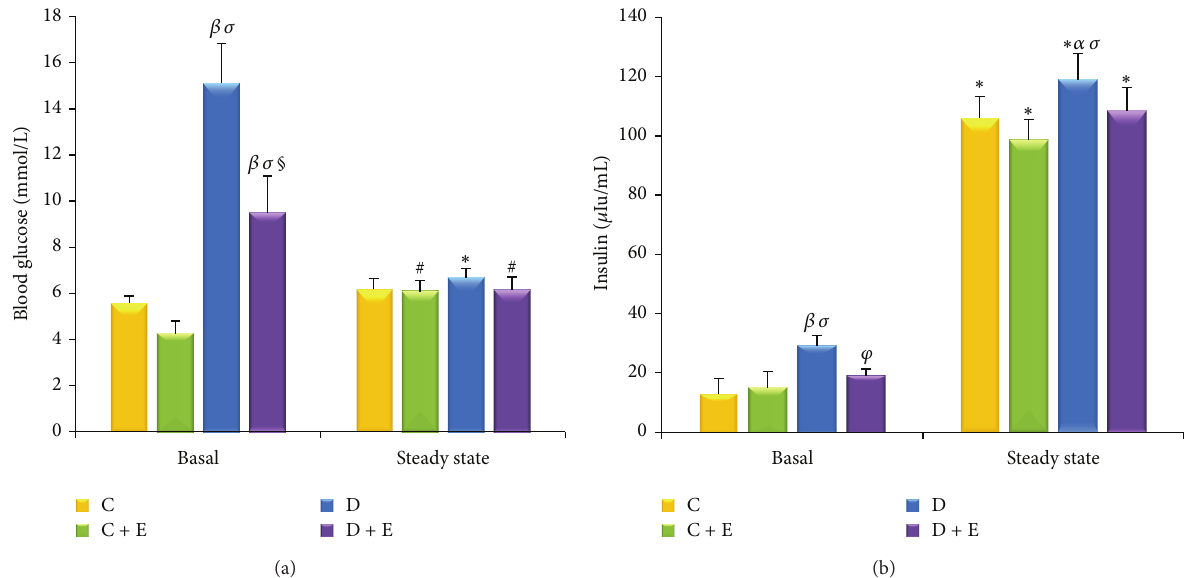
Figure4:Glucoseandinsulinconcentrationduringthehyperinsulinemic-euglycemicclampsteadystate.Theconcentrationsofbloodglucose during the clamp steady state were similar among the four groups of rats. (a) Plasma insulin concentrations of the rats were dramatically elevated compared with their basal state ( 𝑃 < 0.01 ). Furthermore, plasma insulin concentrations in the D group rats were significantly higher than those in the C group rats ( 𝑃 < 0.05 ) and in the C + E group rats ( 𝑃 < 0.01 ) under the clamp steady-state conditions (b). ∗ 𝑃 < 0.01 , # 𝑃 < 0.05 compared with basal. 𝛽 𝑃 < 0.01 , 𝛼 𝑃 < 0.05 compared with C group. 𝜎 𝑃 < 0.01 , 𝛾 𝑃 < 0.05 compared with C + E group. § 𝑃 < 0.01 , 𝜑 𝑃 < 0.05 compared with D